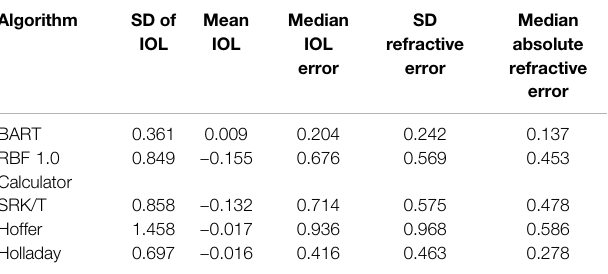
TABLE 2 | Results of fi ve random out-of-sample validations with 20% of the data held out. Algorithm